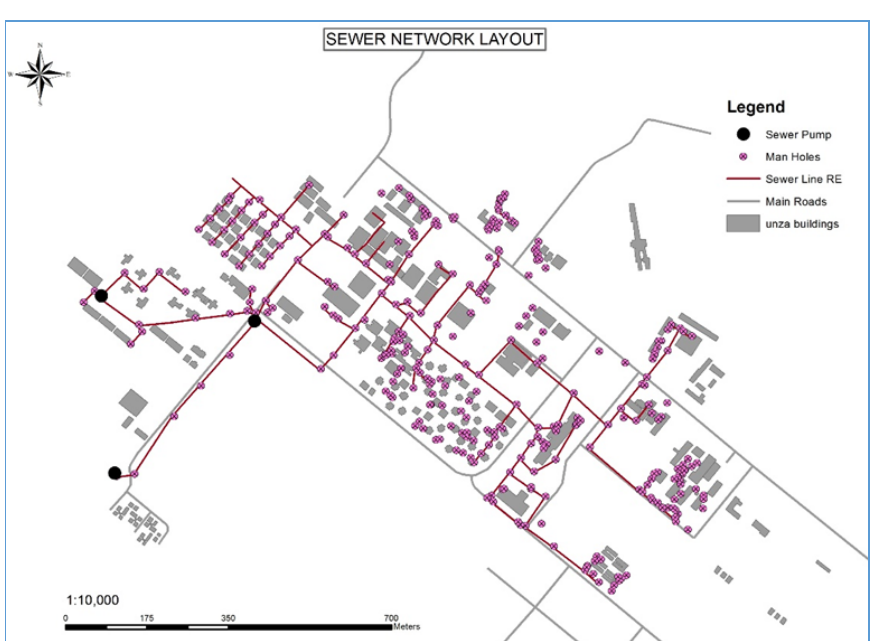
Fig. 9. Updated Sewer